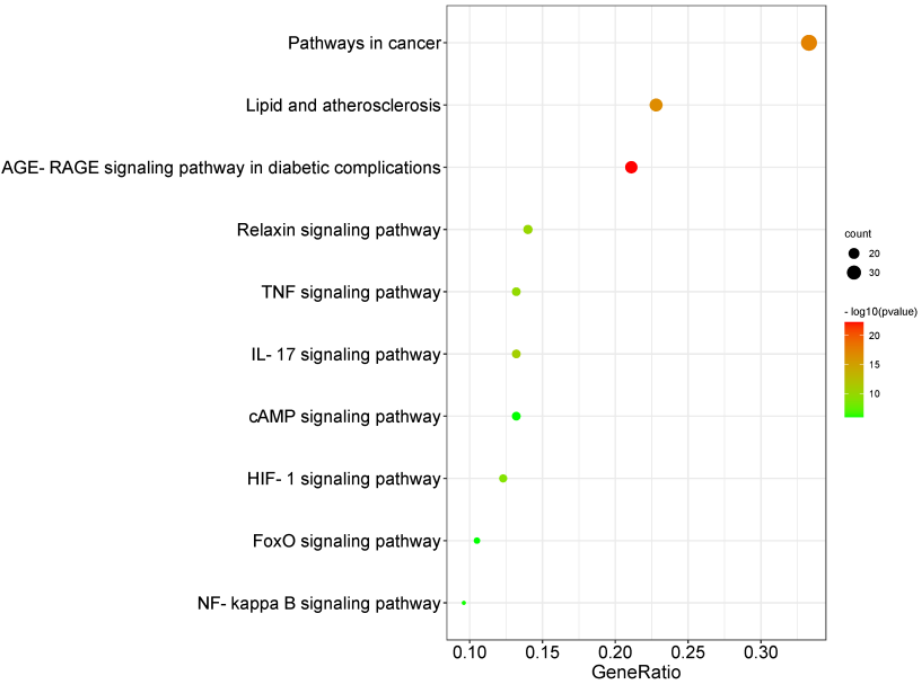
Figure 5. KEGG pathway enrichment of common component – disease targets. The Y-axis represents KEGG pathways. The X-axis indicates the gene ratio enriched in the pathway.